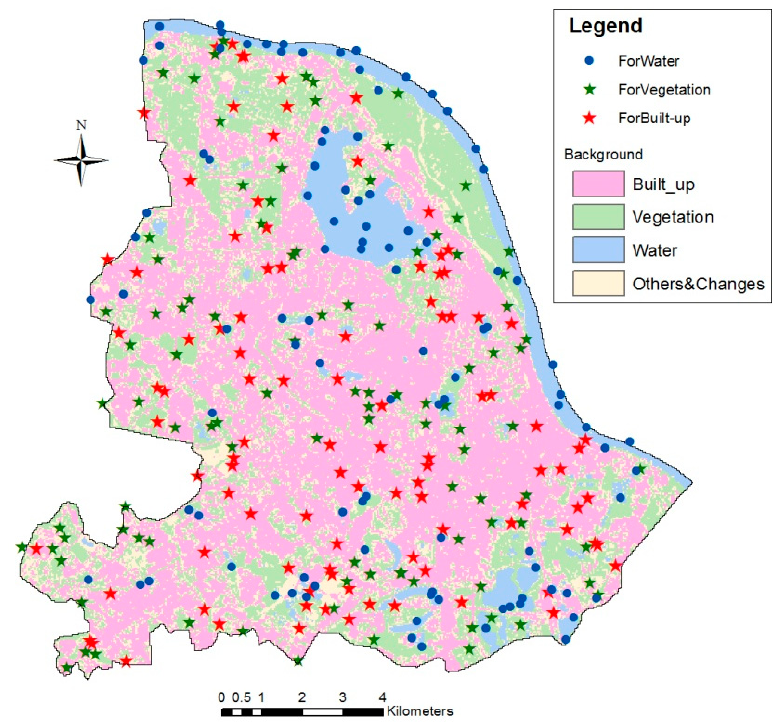
Figure 2. Distribution of the ground truth points on a common area map chosen in the research .